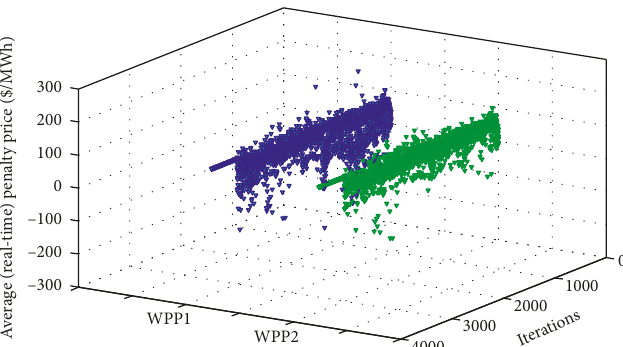
Figure 4: The dynamic adjusting process of (predicted) real-time LMPs connecting WPP1 and WPP2 (penalty prices charging from WPP1 and WPP2) in the GDCAC-based approach.